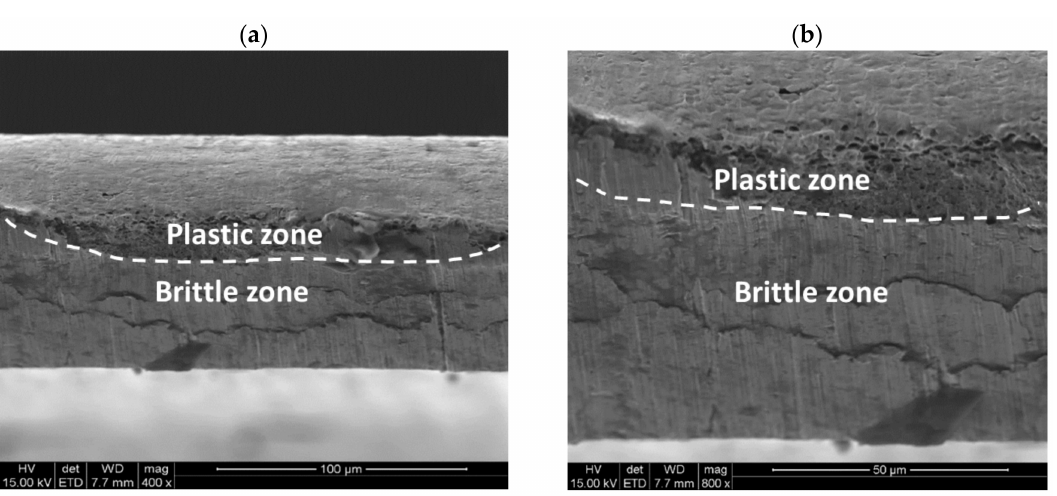
Figure 10. Cross section of the steel sheet being cut showing ductile and brittle zones ( a ) and the magnified part of the cross section showing microscopic details ( b ).